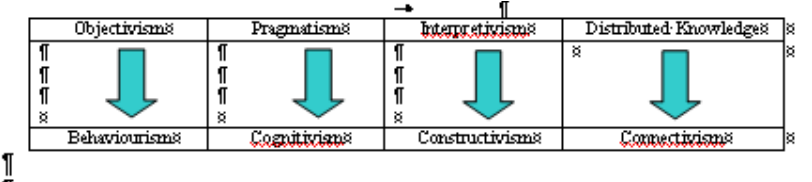
Figure 1. Alignment of Epistemologies and Learning